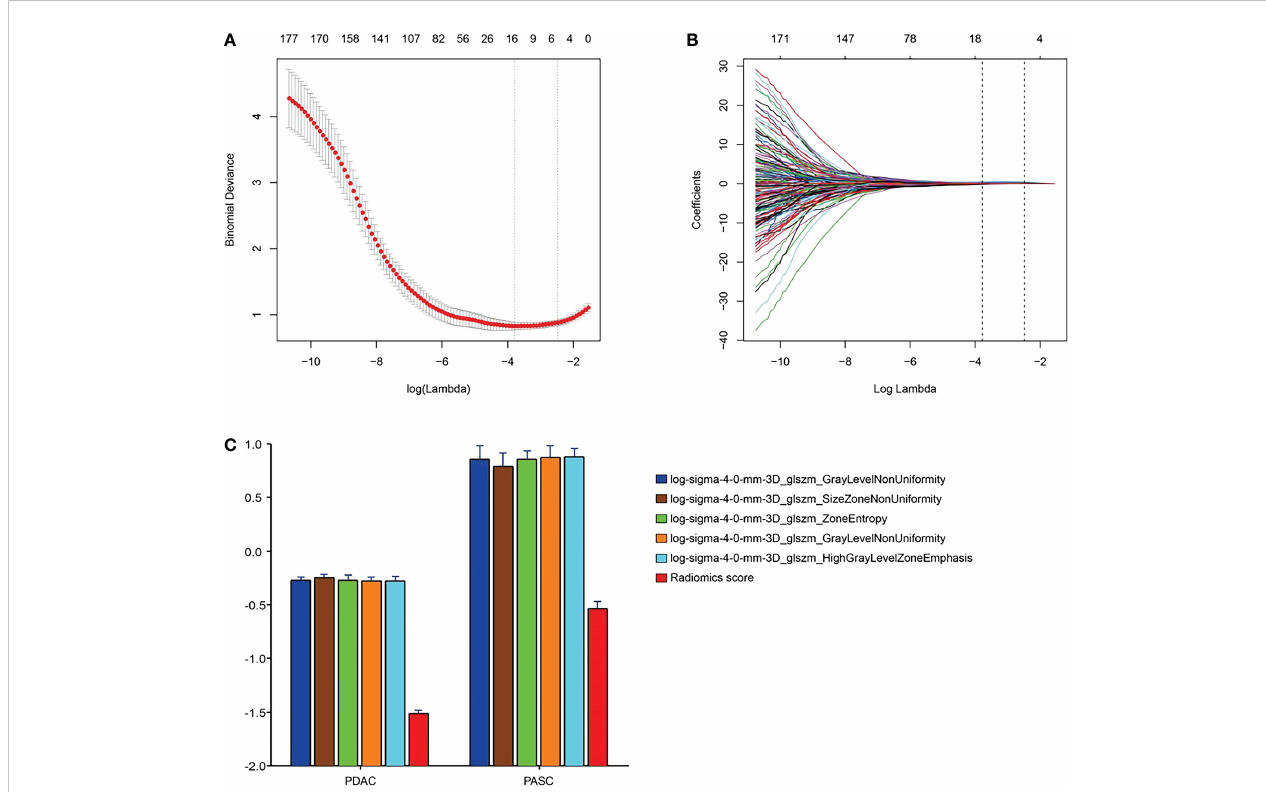
FIGURE 3 Radiomics feature selection using the parametric method, the least absolute shrinkage and selection operator (LASSO). (A) Selection of the tuning parameter ( l ) in the LASSO model via 10-fold cross-validation based on minimum criteria. Binomial deviances from the LASSO regression cross- validation procedure were plotted as a function of log( l ). The y-axis indicates binomial deviances. The lower x-axis indicates the log( l ). Numbers along the upper x-axis represent the average number of predictors. Red dots indicate the average deviance values for each model with a given l , and vertical bars through the red dots show the upper and lower values of the deviances. The vertical black lines de fi ne the optimal values of l , where the model provides its best fi t for the data. The optimal l value of 0.08 with log( l ) = -2.48 was selected. (B) LASSO coef fi cient pro fi les of the 328 features. The dotted vertical line was plotted at the selected value using 10-fold cross-validation. The fi ve resulting features with nonzero coef fi cients are indicated in the plot. (C) The error-bar chart of the fi ve radiomics features and radiomics